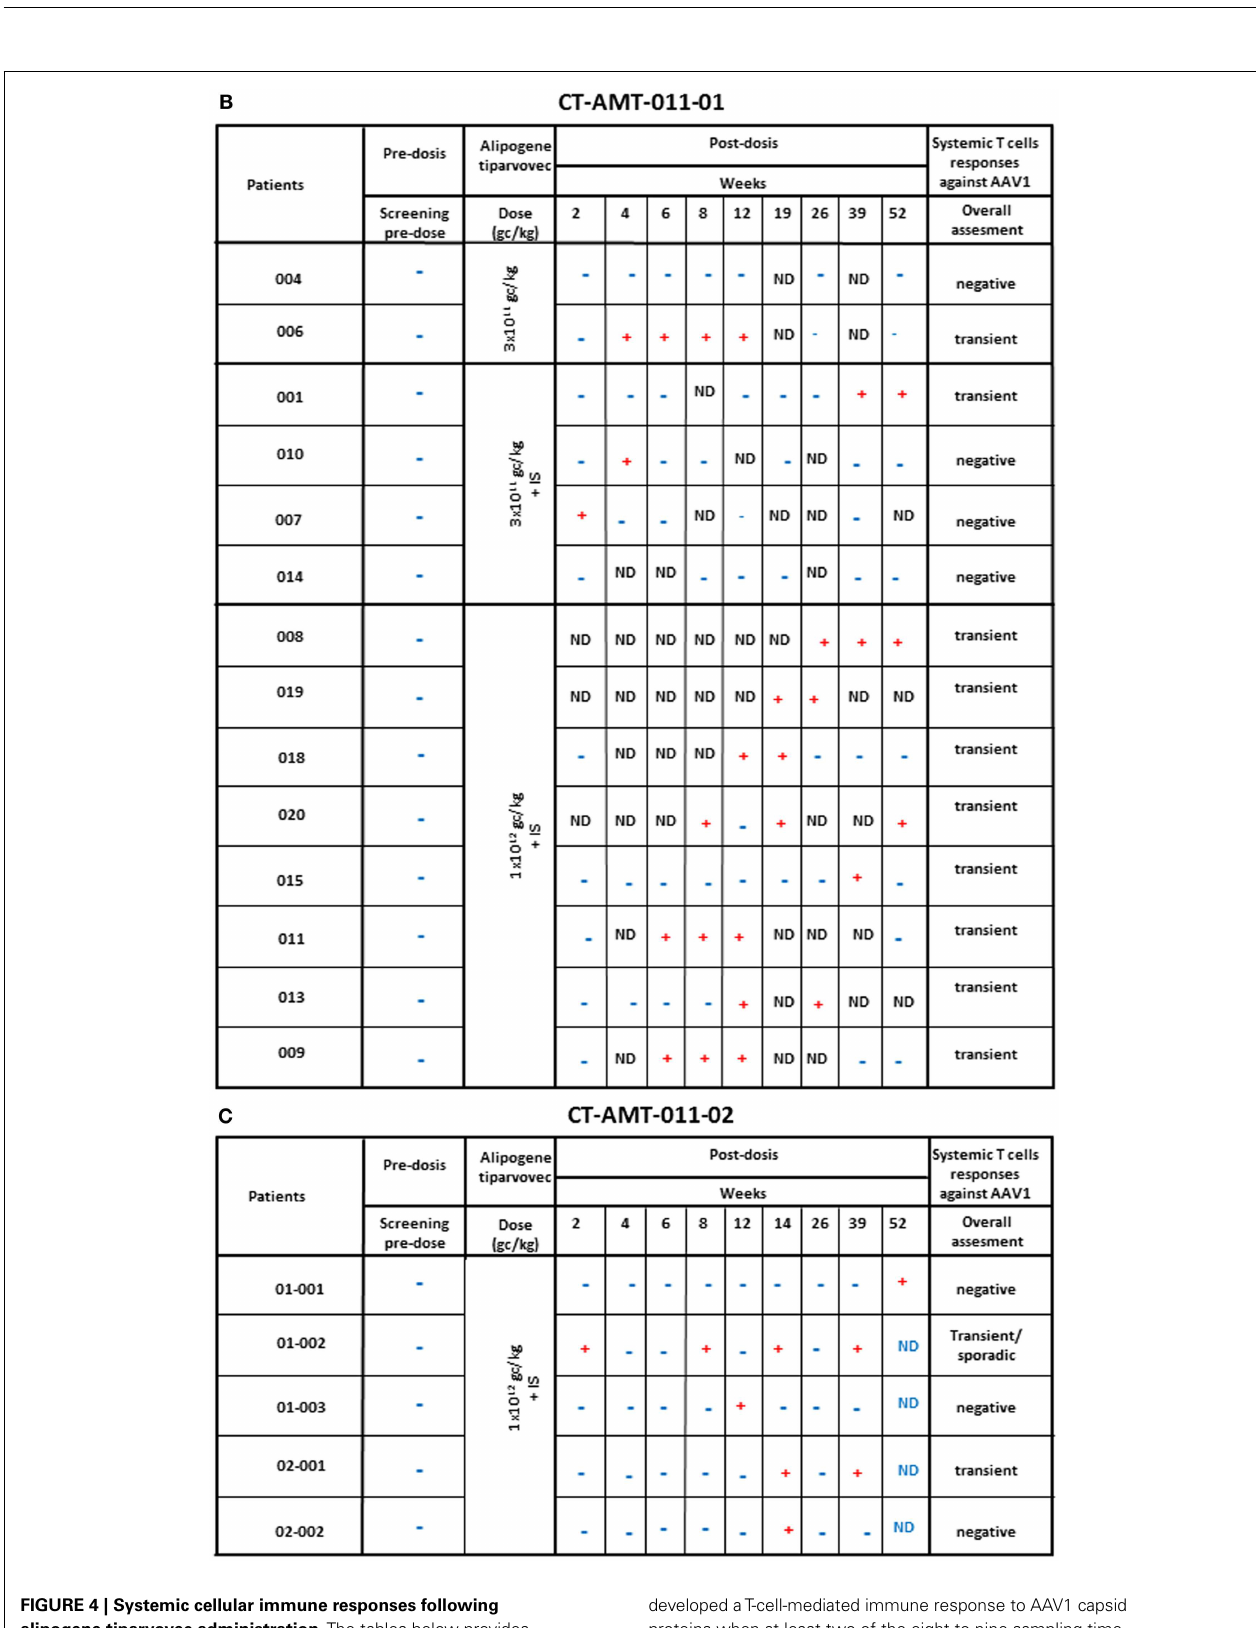
FIGURE 4 | Systemic cellular immune responses following alipogene tiparvovec administration .The tables below provides an overview of the individual patient systemicT-cell response against AAV1 overtime for study CT-AMT-010 (A) , study AMT-011-01 (B) , and study AMT-011-02 (C) .We considered that a subject